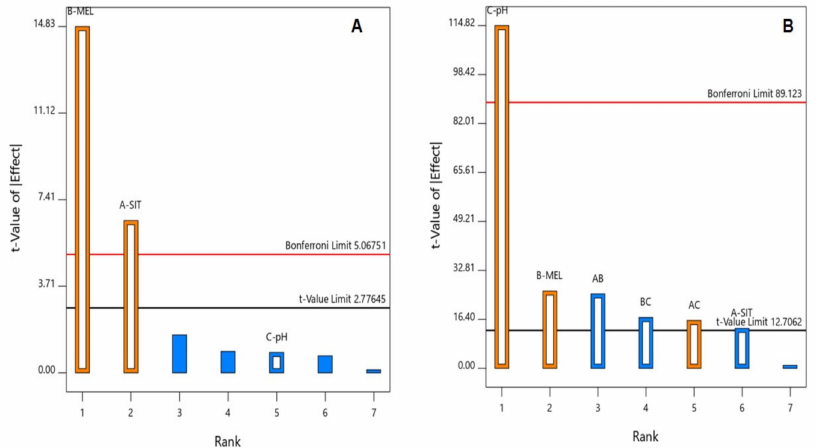
Figure 1. Standardized Pareto chart for the ( A ) particle size and ( B ) zeta potential of SIT-MEL nano-sized systems.